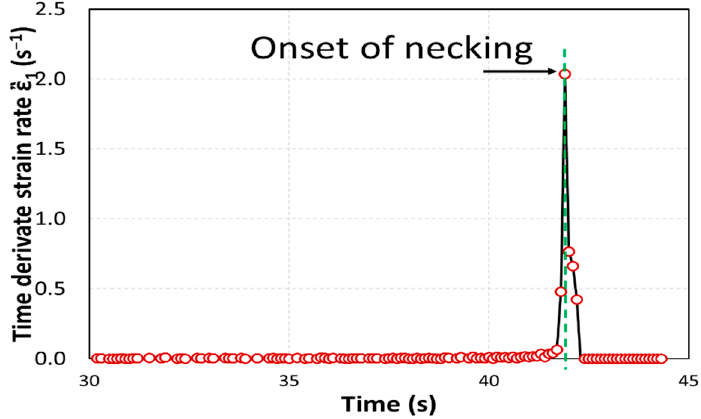
Figure 2. Determination of the FLD values, time-dependent method.